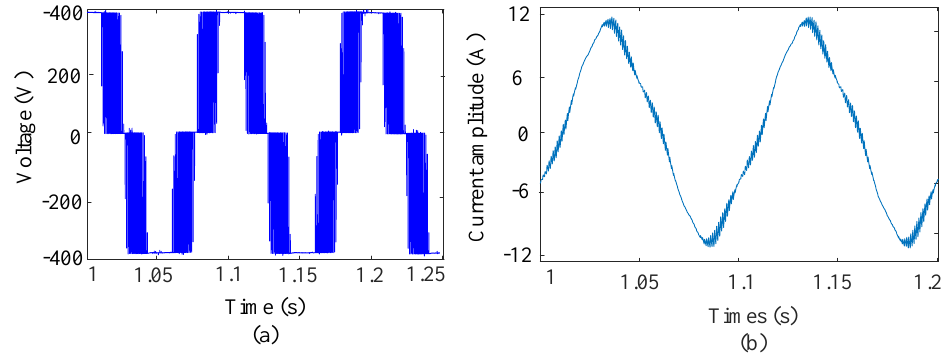
Figure 5. ( a ) Voltage waveform, ( b ) current waveform.